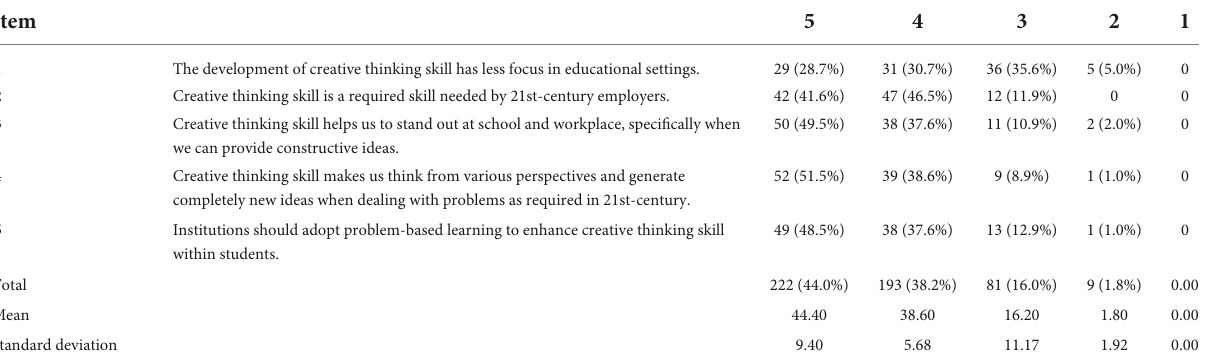
TABLE 4 Creative thinking